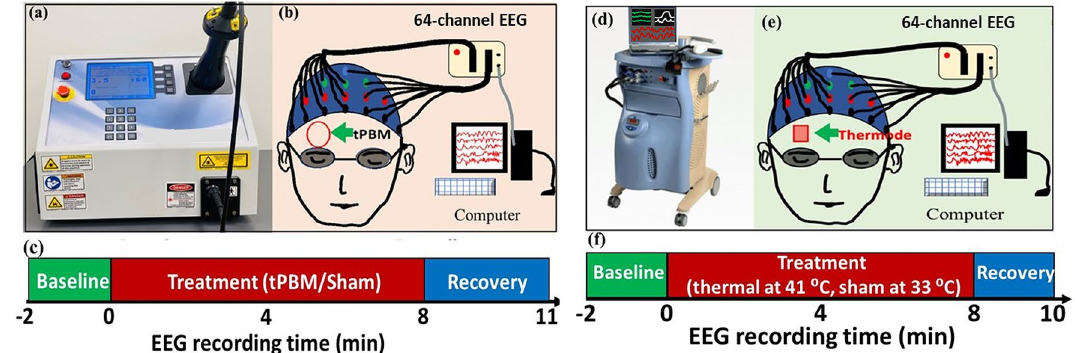
Figure 1. Experimental setups and protocols for concurrent tPBM/EEG and thermo_stim/EEG measurements. ( a ) Photo of FDA-cleared, 1064-nm, continuous-wave laser (Model CG-500). ( b ) Schematic diagram of the experimental setup: 64 electrodes of an EEG device were attached to an international 10–10 standard EEG cap, while the subject was wearing a pair of safety goggles and retained in eye-closed resting state during the sham or active tPBM condition. The laser aperture was pointed at the right forehead of the subject with 2-cm away from the skin. ( c ) The experimental protocol including a 2-min baseline, 8-min stimulation (with a laser power of 3.5 W for tPBM and 0 W for sham), and a 3-min recovery period. ( d ) Picture of the thermal stimulator system (Pathway model with ATS thermode). ( e ) Schematic diagram of the EEG setup used when the subject retained stimulation: a 2-min baseline, 8-min thermo_stim, and a 2-min recovery